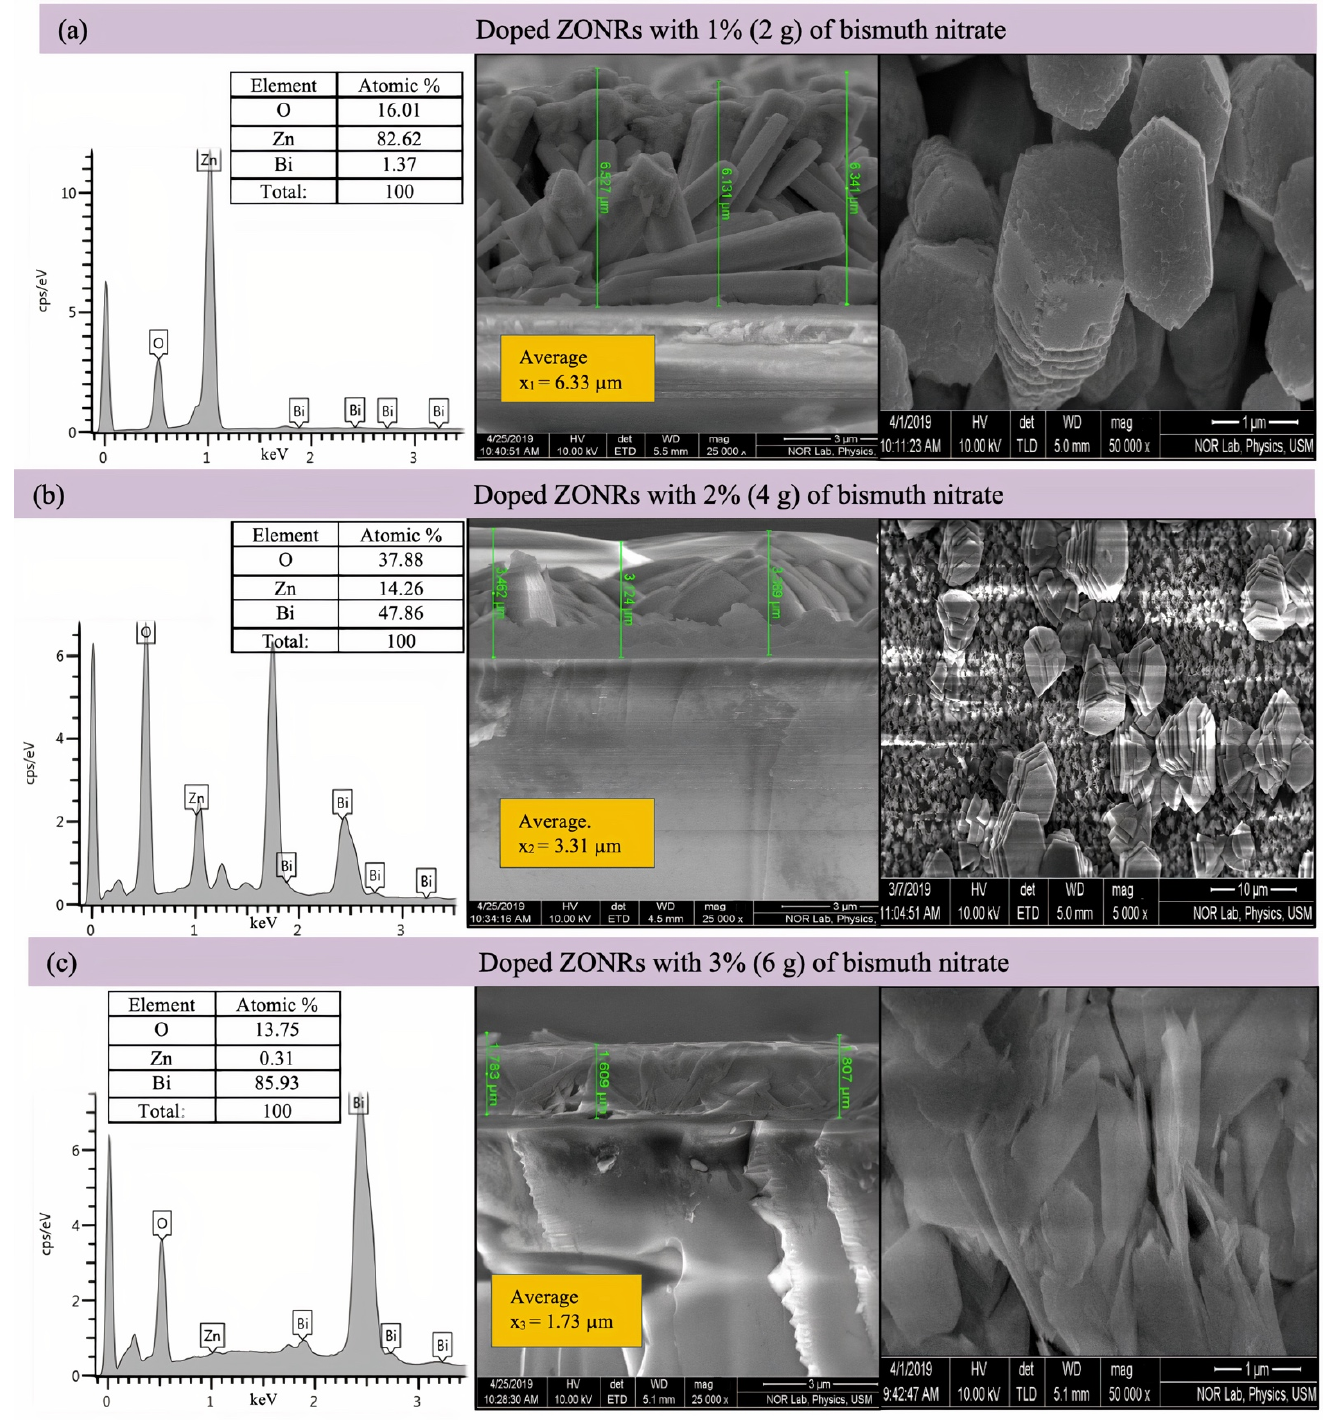
Figure 7. Cross-sectional FESEM images ( right ) and EDX spectra ( left ) of ZONRs-TFs doped with 1–3 wt.% of BN. Inset: EDX Atomic% of detected trace elements.